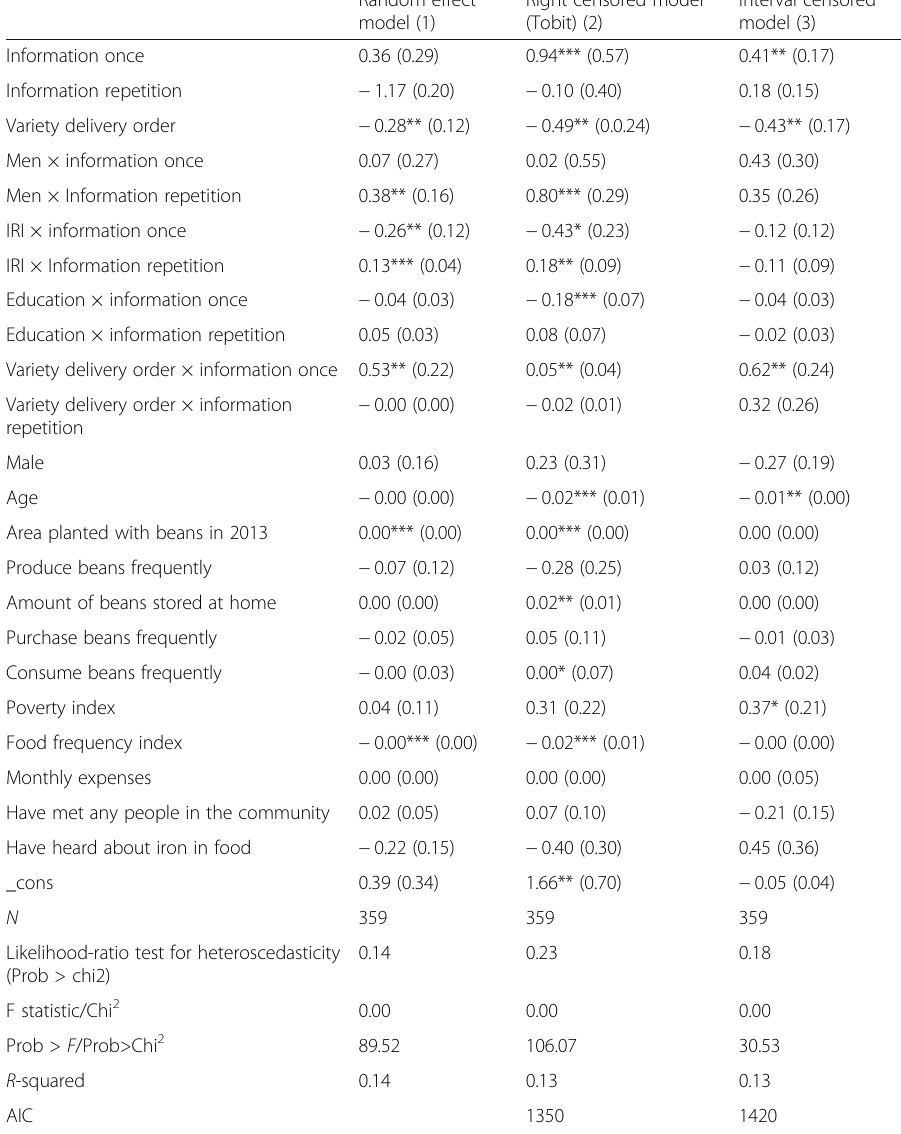
Table 5 Determinants of WTP premium for the iron-enriched bean variety in Guatemala — random effects model, right-censored model and interval-censored model Random effect model